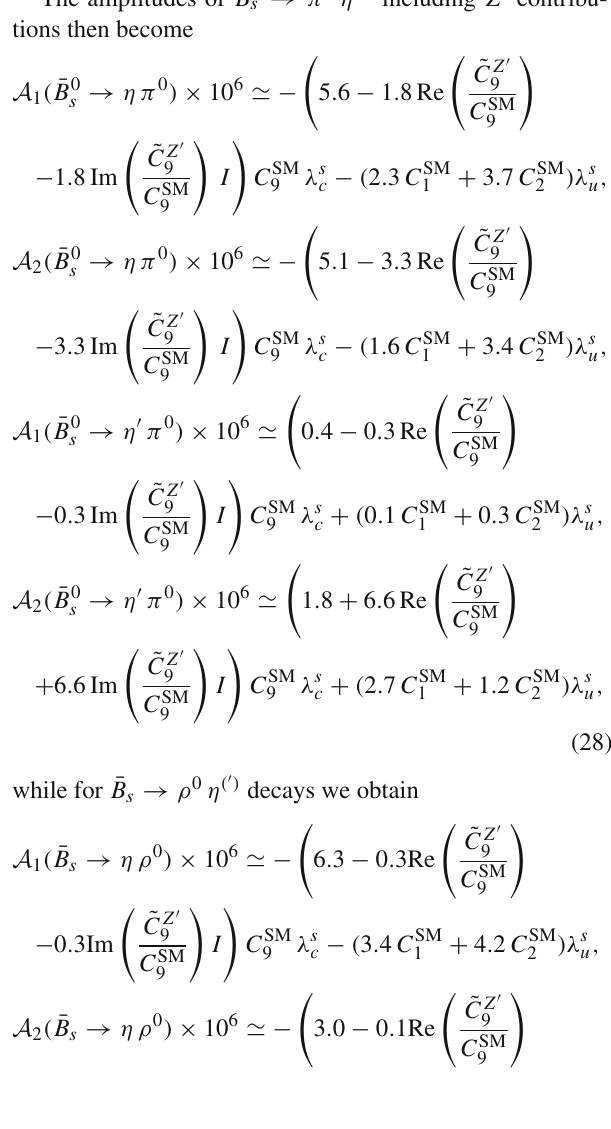
Fig. 1 Left allowed regions in the Re ((cid:5) bs where red ( blue ) color corresponds to the bounds on (cid:5) M B Middle allowed regions in the Re ((cid:5) bs bounds on (cid:5) M B